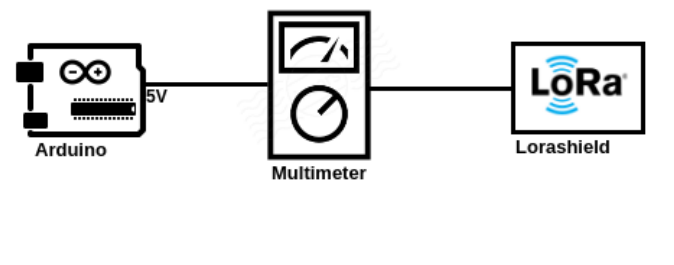
Figure 12. Energy measurement